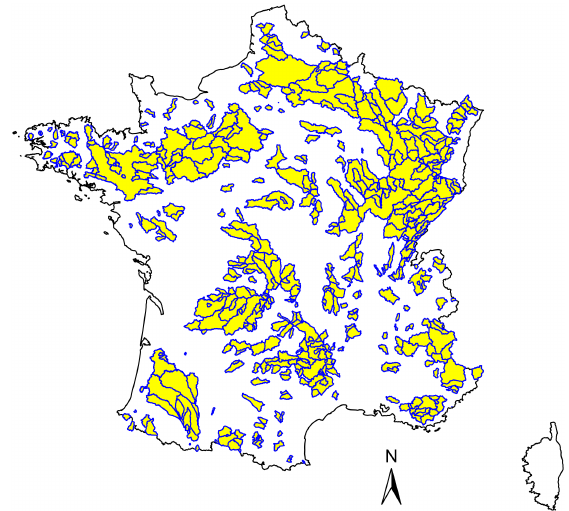
Figure 1. Locations of the 519 French catchments analyzed in this study.